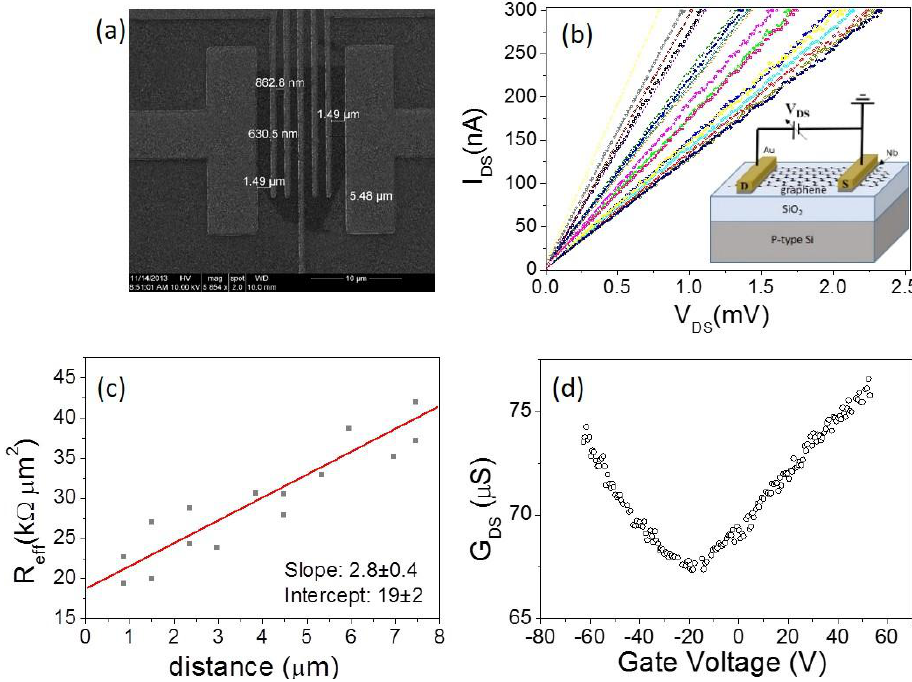
Figure 1. ( a ) A transfer length method (TLM) device with Nb(15 nm)/Au(25 nm) contacts. ( b ) Current–voltage characteristics measured for all possible two-lead combinations in the TLM device, at V Gate = 0 V; inset: scheme of the device. ( c ) TLM plot of R eff (L) at V Gate = 0 V. ( d ) Transfer characteristic of one of the back-gated transistors of (a) in the range −60 V < V Gate < +60 V.